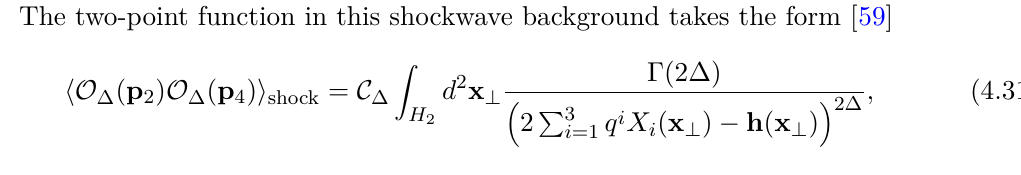
and Ω parameterize S 2 constant τ boundary slices. Right: 2 4 inserted around τ 0 = − π and τ 0 = π respectively becomes 2 , p 4 2 4 2 2